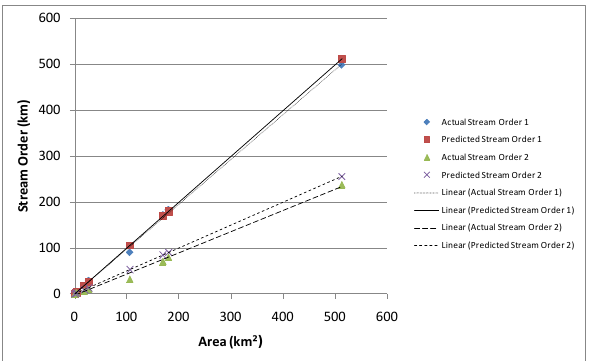
Figure 10, Upper Oaky Creek –Land Use Area v Actual Stream Order 1 and 2 Waterways, Predicted